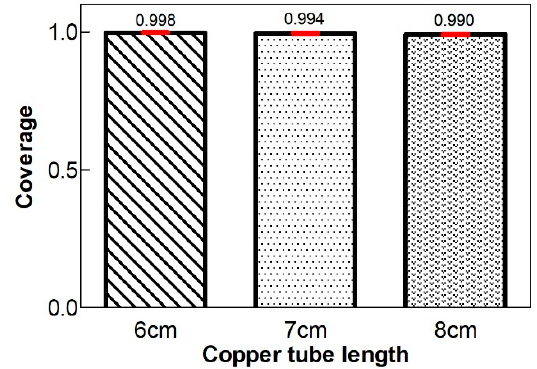
Figure 15. Coverage comparison based on length of aerosol inlet tube.